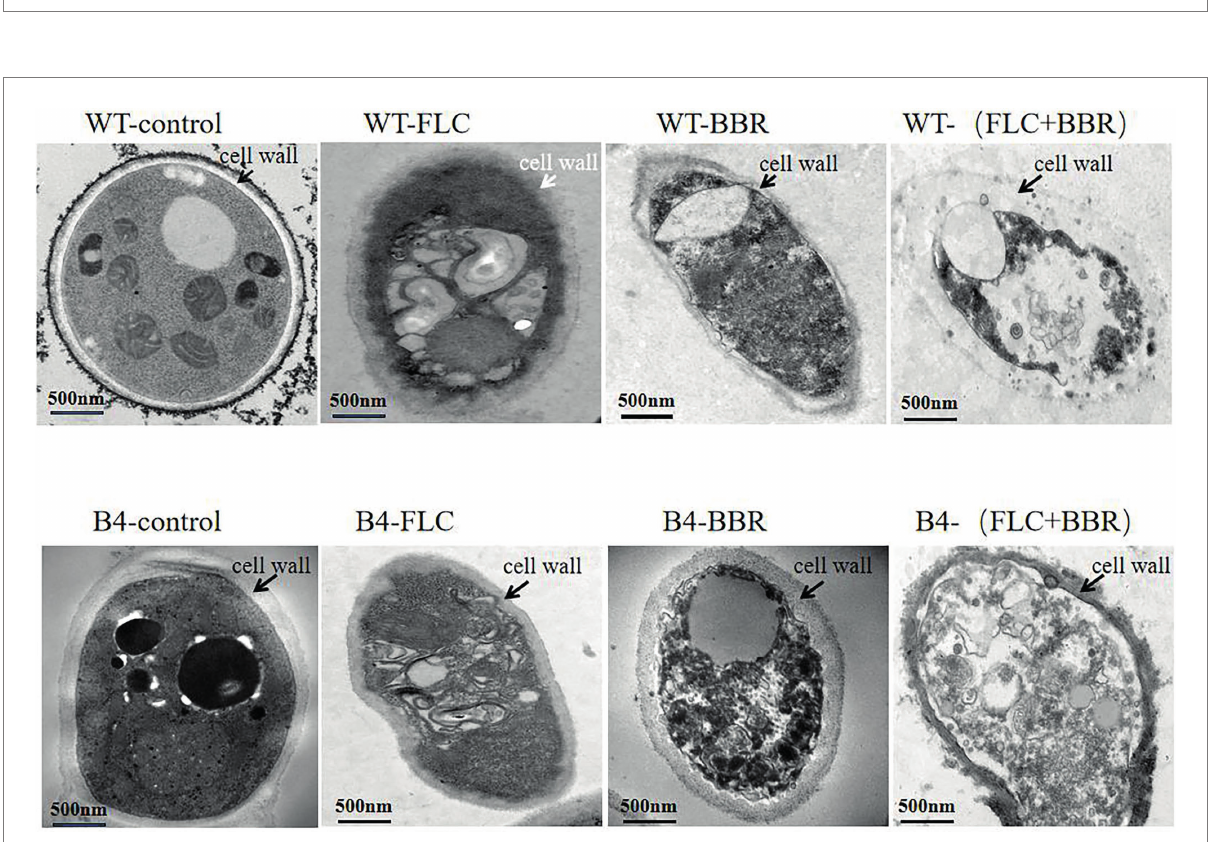
FIGURE 2 Transmission electron microscopy observation of cells (WT,B4) before and after using FLC or/and BBR. For (WT) , add BBR 32 μ g/ml, FLC 2 μ g/ml, BBR/FLC 32 μ g/ml + 2 μ g/ml; For (B4) , add BBR 32 μ g/ml, FLC 256 μ g/ml, BBR/FLC 32 μ g/ml+ 256 μ